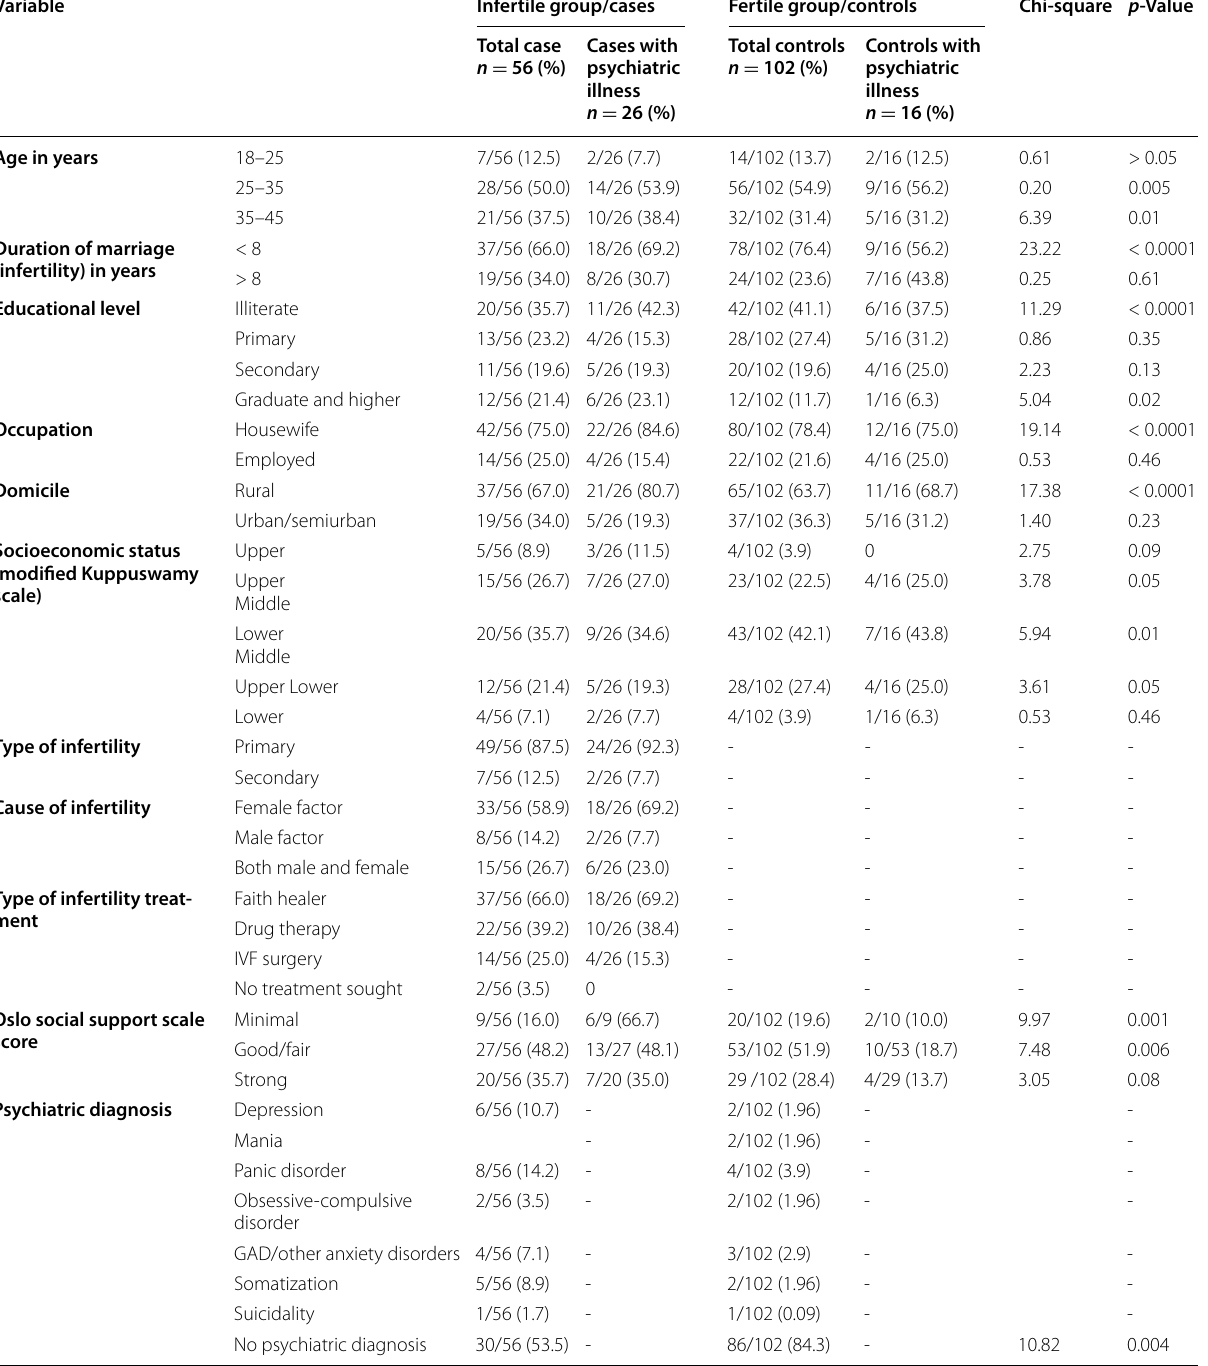
Table 1 Comparison between infertile group and fertile group as regard sociodemographic and clinical variables (denominators indicate the respective proportions) Variable Infertile group/cases Fertile group/controls Chi-square p